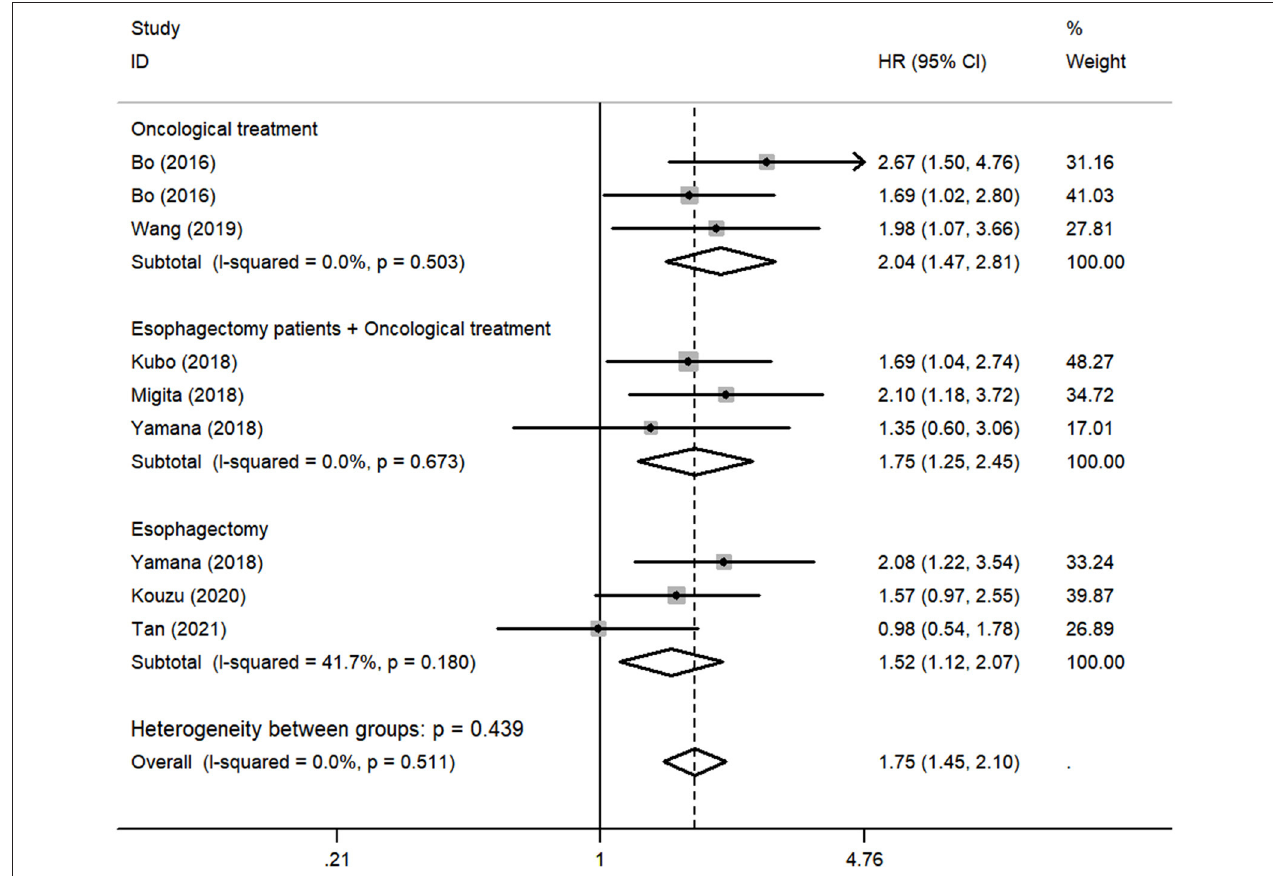
FIGURE 4 | Forest plot showing subgroup analysis of the selected studies about the prognostic significance of GNRI in patients with different